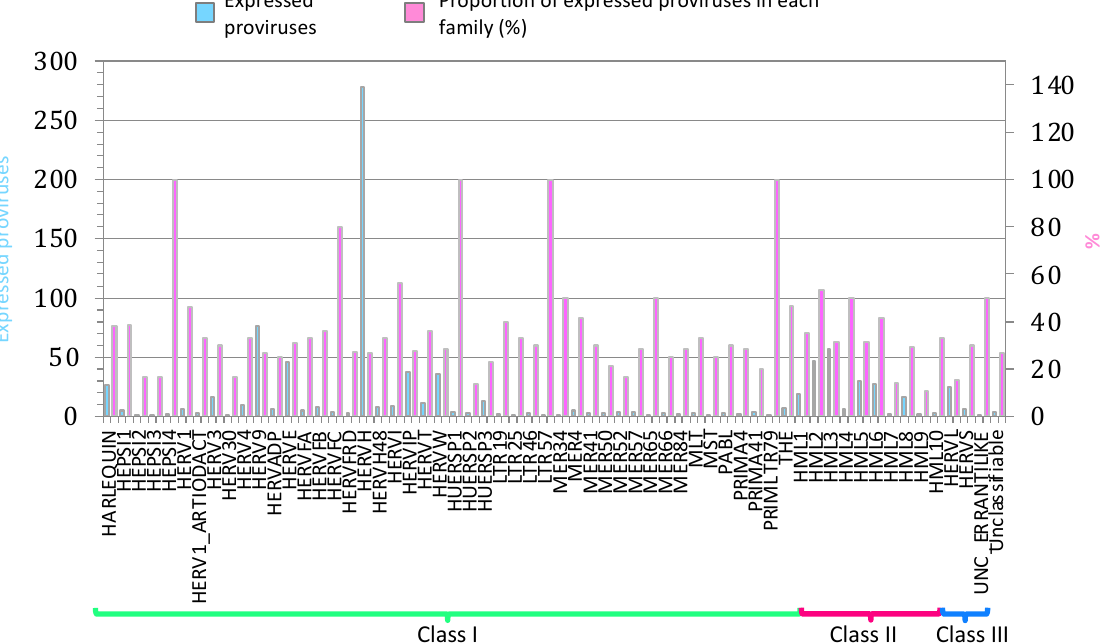
Figure 1. ReTe HERV transcriptome in PBMCs. Basal expression of the most intact HERV loci as reported in Vargiu et al. All the expressed elements are grouped by retroviral classes and groups. Light blue bars indicate the absolute number of expressed proviruses in each retroviral group, while pink bars indicate the percentage of expressed proviruses among each group's total members .